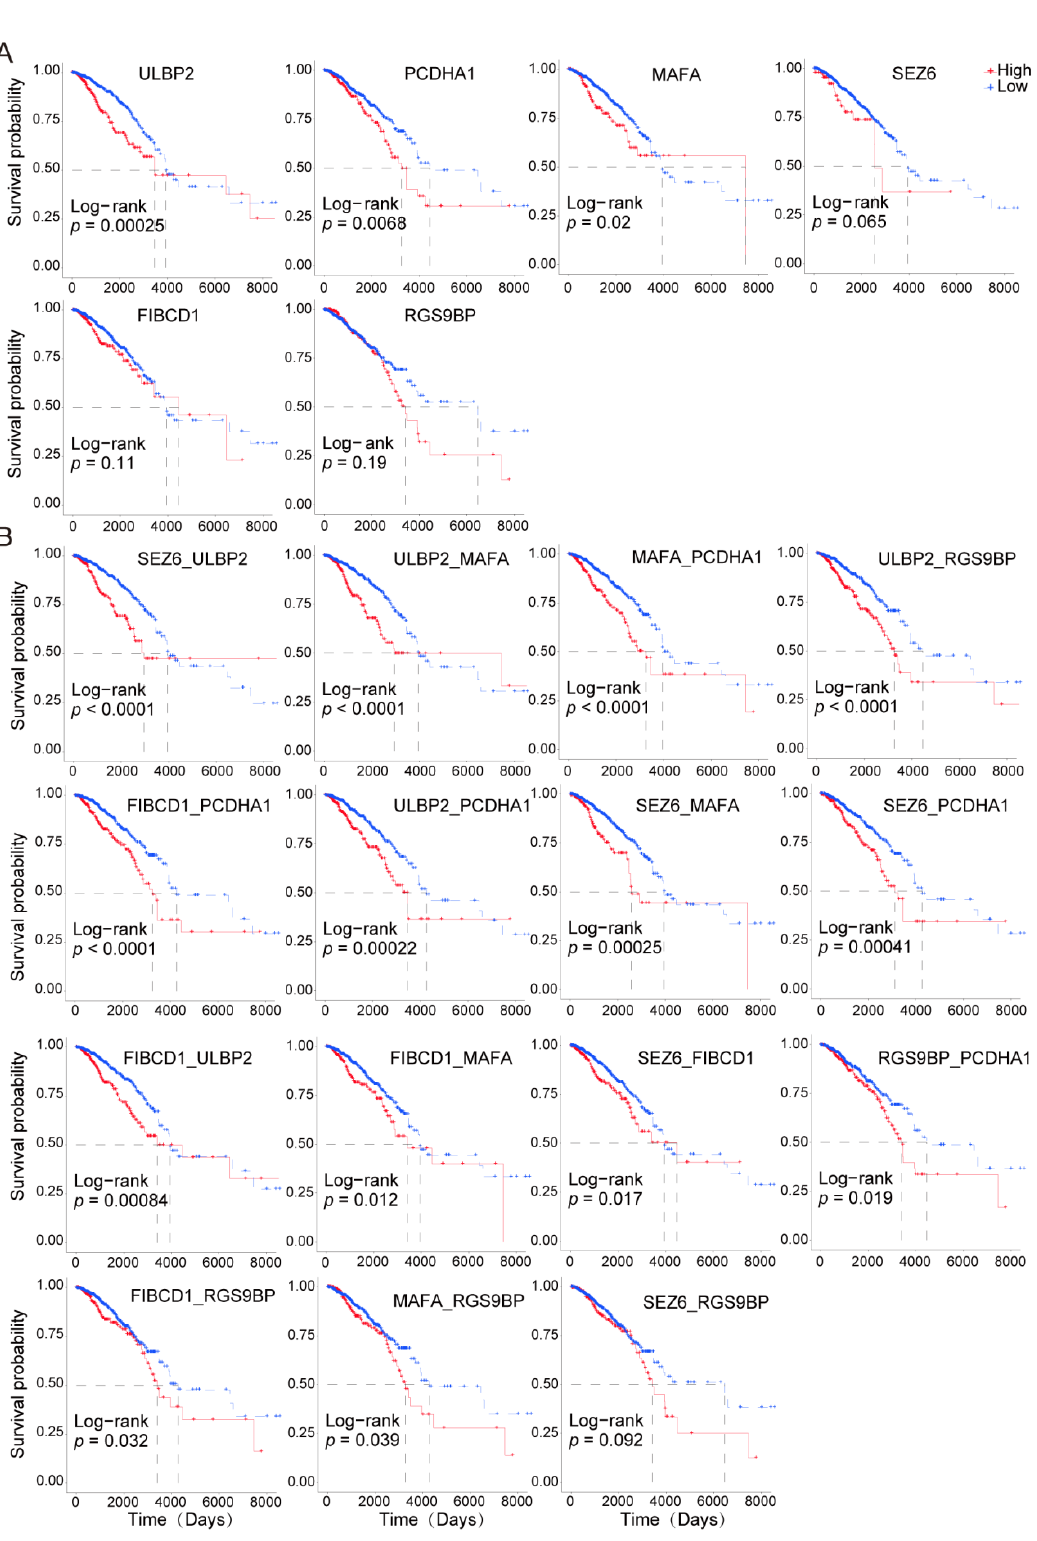
Figure 4. Survival analysis of individual or paired specific high-expression and poor prognosis- associated membrane surface protein-coding genes in BRCA patients. ( A ). KM curves display the prognostic roles of the selected membrane protein-coding genes in cancer patients. ( B ). KM curves display the prognostic roles of the selected membrane protein-coding genes in cancer patients. The red lines indicate the high-expression group. The blue color lines indicate the low-expression group. High-expression and low-expression groups were divided by the mean value of the gene expression. p < 0.05 was considered significantly different.